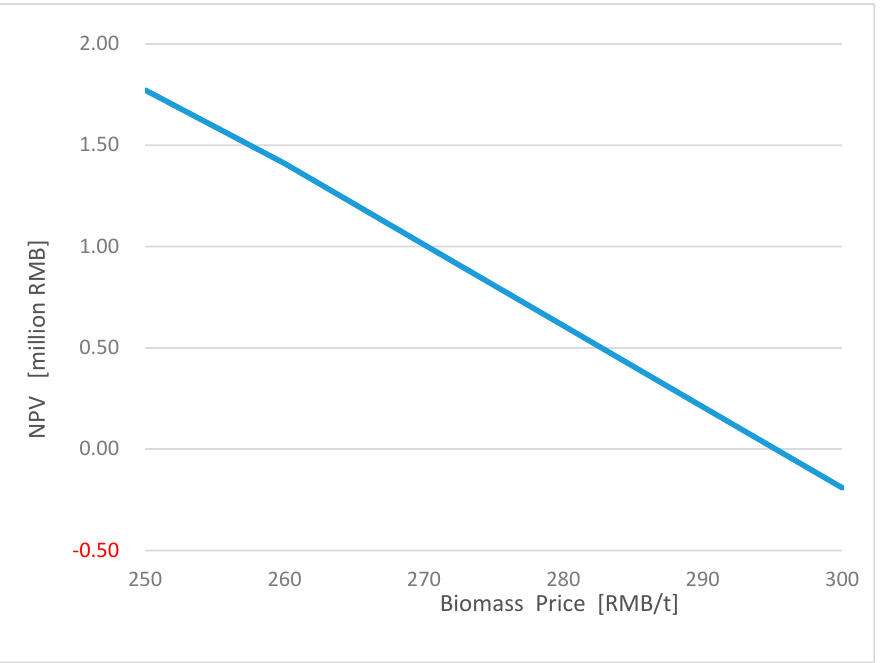
Figure 8. Functional relationship between biomass price and NPV.